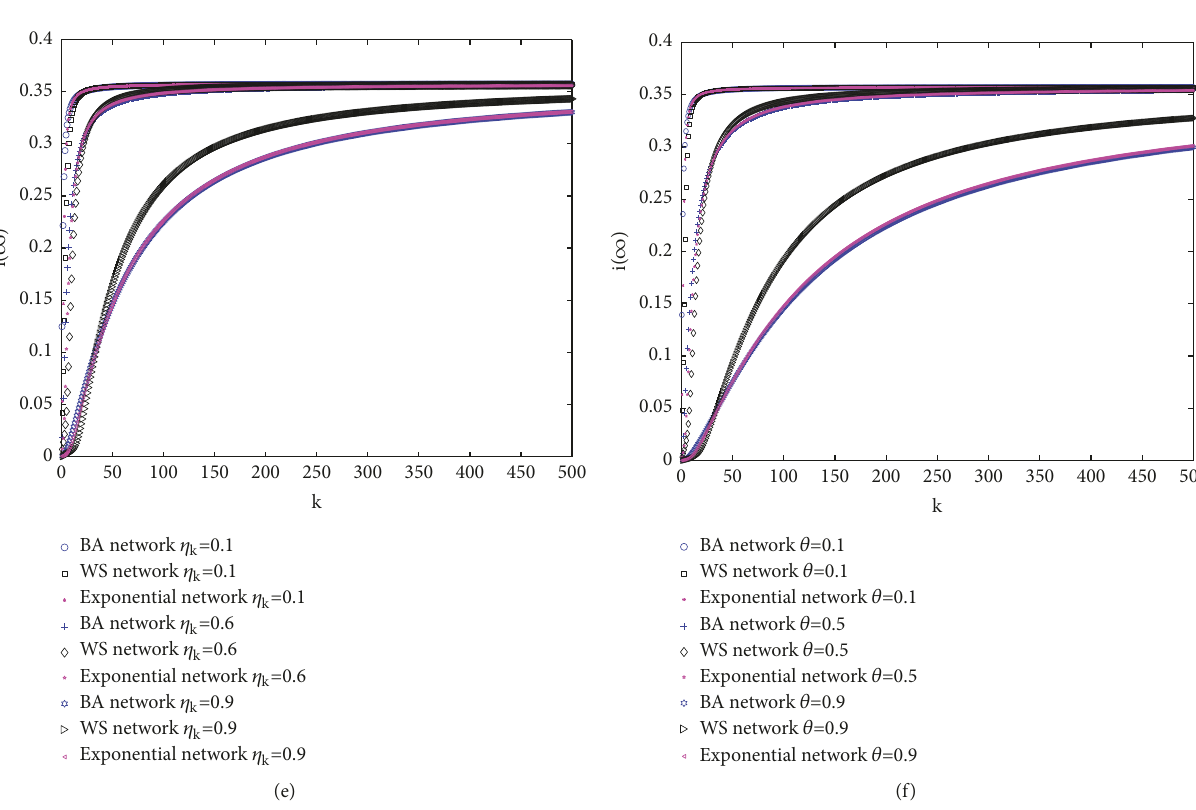
Figure 7: Change rules of the scale 𝑖(∞) of the health food safety scare behavior diffusion. (a) Effects of the health food safety information transparency 𝜃 on 𝑖(∞) under different network structures and recovery rates 𝜇 (where 𝜆 0 = 0.001 , 𝛽 = 0.5 , 𝜂 𝑘 = 0.7 , and 𝑘 = 1000 ). (b) Effects of the degree 𝑘 of health food consumers’ ability to process information 𝜂 𝑘 on 𝑖(∞) under different network structures and recovery rates 𝜇 (where 𝜆 0 = 0.005 , 𝛽 = 0.5 , 𝜃 = 0.7 , and 𝑘 = 1000 ). (c) Effects of the health food safety information transparency 𝜃 on 𝑖(∞) under different network structuresand degree 𝑘 of health food consumers’ability to process information 𝜂 𝑘 (where 𝜆 0 = 0.001 , 𝛽 = 0.5 , 𝜇 = 0.9 , and 𝑘 = 1000 ). (d) Effects of the degree 𝑘 of health food consumers’ ability to process information 𝜂 𝑖(∞) under different network structures 𝑘 on and health food safety information transparency 𝜃 (where 𝜆 0 = 0.001 , 𝛽 = 0.5 , 𝜇 = 0.9 , and 𝑘 = 1000 ). (e) Effects of the degree 𝑘 of health food consumers on 𝑖(∞) under different network structures and degree 𝑘 of health food consumers’ ability to process information 𝜂 𝑘 (where 𝜆 = 0.001 , 𝛽 = 0.5 , 𝜇 = 0.9 , and 𝜃 = 0.1 ). (f) Effects of the degree 𝑘 of health food consumers on 𝑖(∞) under different network structures 0 and health food safety information transparency 𝜃 (where 𝜆 0 = 0.001 , 𝛽 = 0.5 , 𝜇 = 0.9 , and 𝜂 𝑘 = 0.01